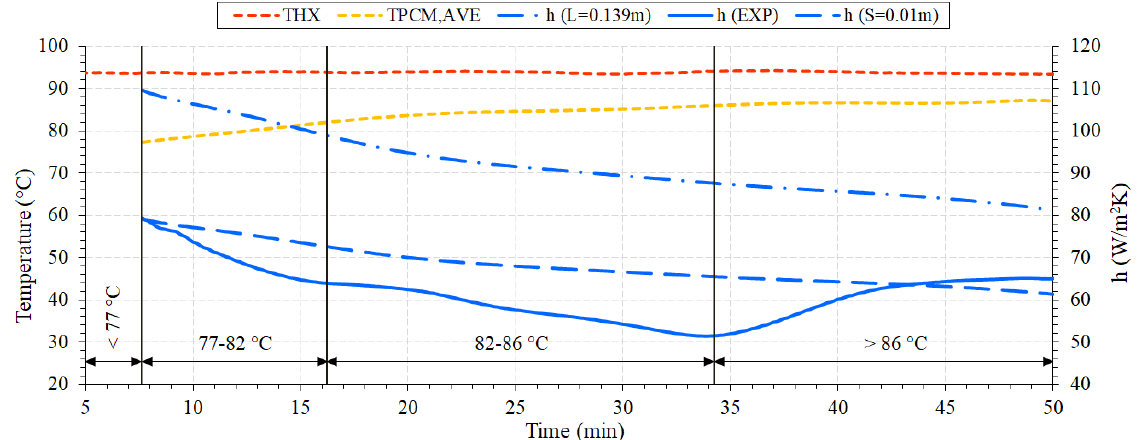
Figure 7. Average heat transfer coefficient: h (EXP)—experimental, h ( L = 0.139 m)—theoretical (characteristic length fin height), h (S = 0.01 m)—theoretical (characteristic length fin spacing).